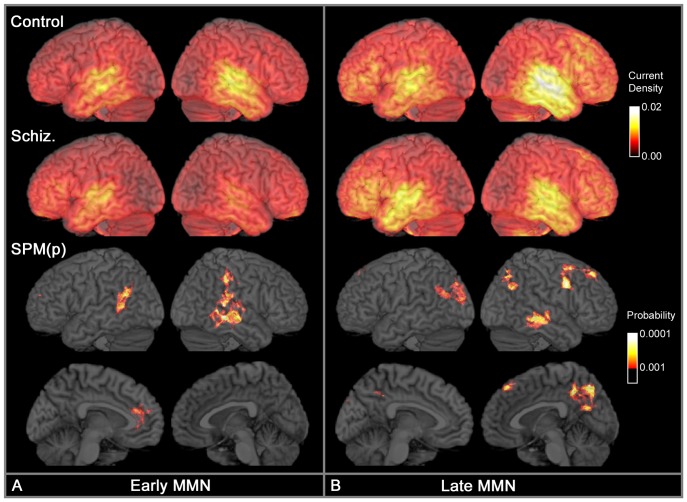
Comparison of CSD in controls and schizophrenia.Comparison of CSD in controls and schizophrenia during (A) Early MMN (110–160 ms), and (B) Late MMN (160–210 ms). Upper two rows display CSD magnitude with maximal activity in lighter colours. CSD has units of micro-Amperes per millimetre squared and has a maximum value of 0.021 µA/mm2 in the data illustrated. The medial surfaces are not illustrated as they showed no patterns of focal CSD activity. The lower two rows display clusters in which controls have greater CSD than patients. This is a statistical parameter map (SPM) of the probability that the two groups differ, thresholded at p<.001 (uncorrected); cluster size >1 cm3. There were no clusters in which patients had larger CSD than controls.